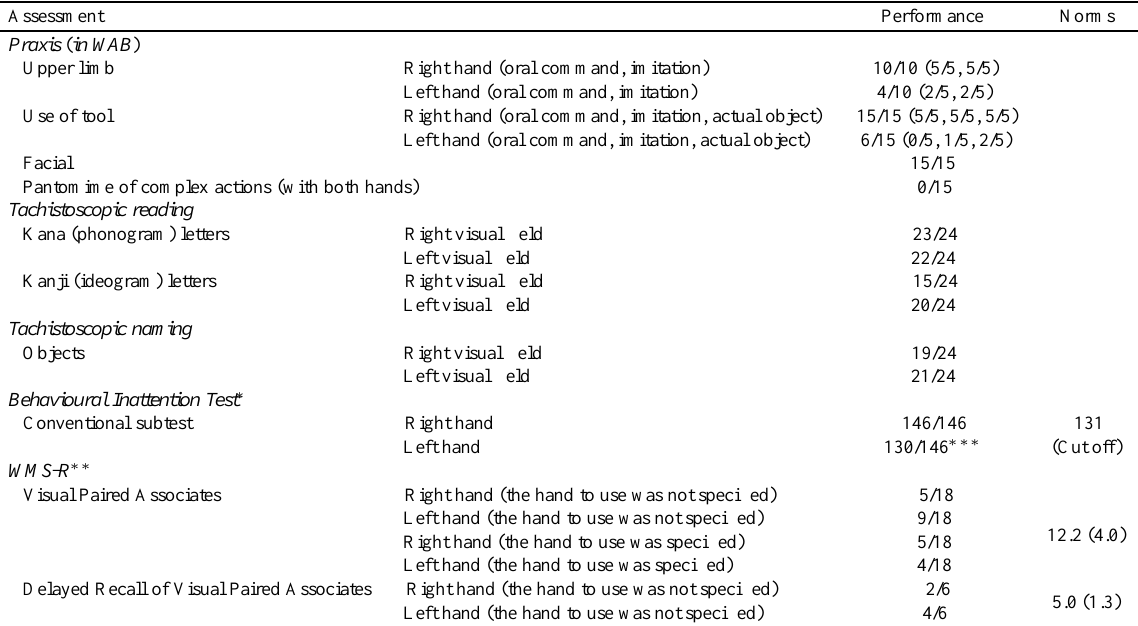
Table 2 Neuropsychological findings relevant to callosal